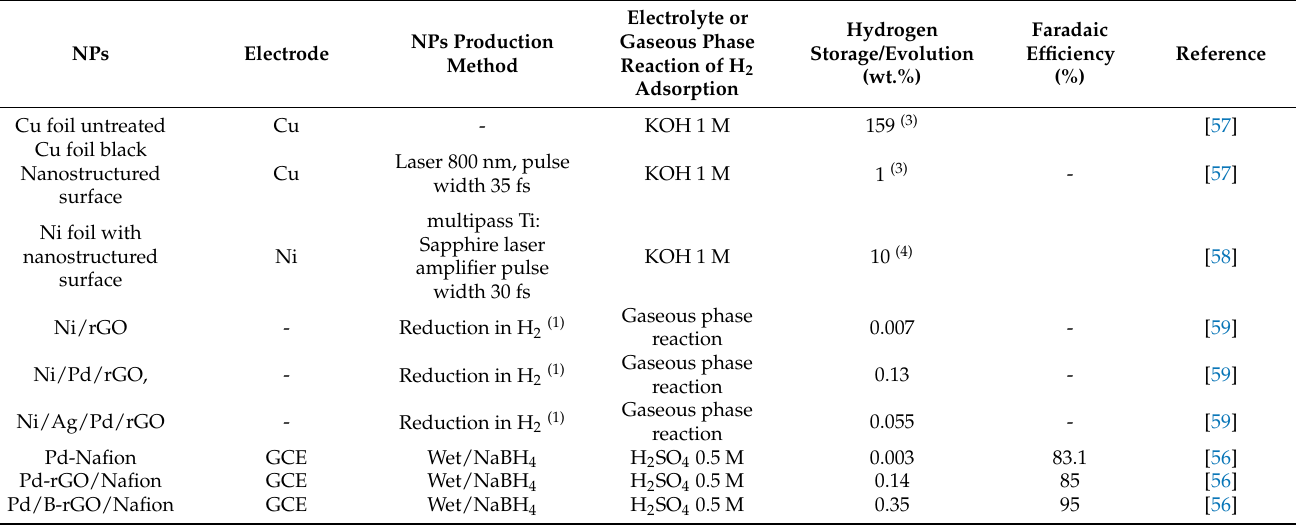
Table 2. Evolution and adsorption of hydrogen by the Pt, Pd, PtPd, Cu(OH) 2 , Pt -Nafion, Pd -Nafion, PtPd -Nafion, and Cu(OH) 2 -Nafion, in comparison to platinum, copper, nickel, and palladium nanoparticles-decorated carbon nanomaterials reported in the